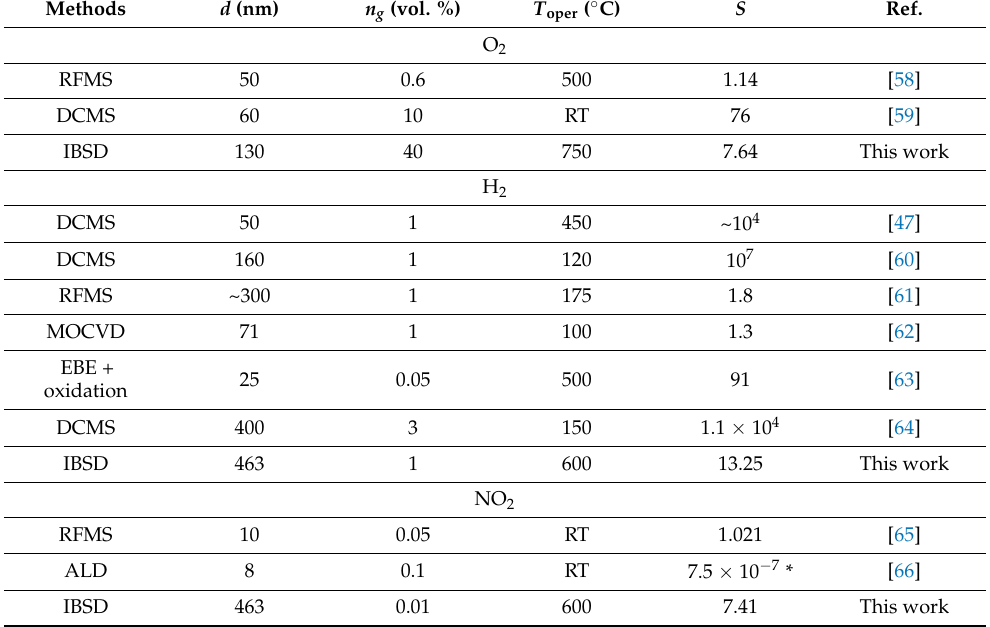
Table 5. Comparison of sensitivity to O 2 , H 2 and NO 2 for thin films deposited by different CVD and PVD methods.